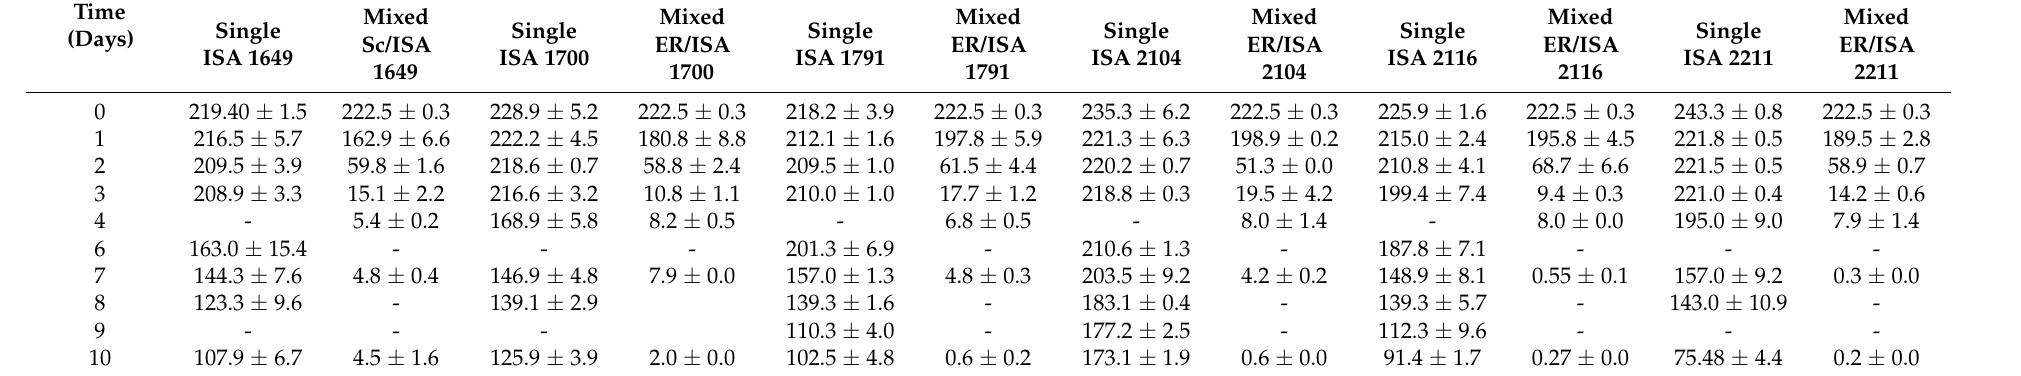
Table 1. Sugars consumption during alcoholic fermentations performed with the B. bruxellensis strains ISA 1649, ISA 1700, ISA 1791, ISA 2101, ISA 2116 and ISA 2211 in single- and in mixed-culture with S. cerevisiae Ethanol Red (ER). Data presented correspond to means ± SD of two independent biological assays, each analyzed in triplicate.